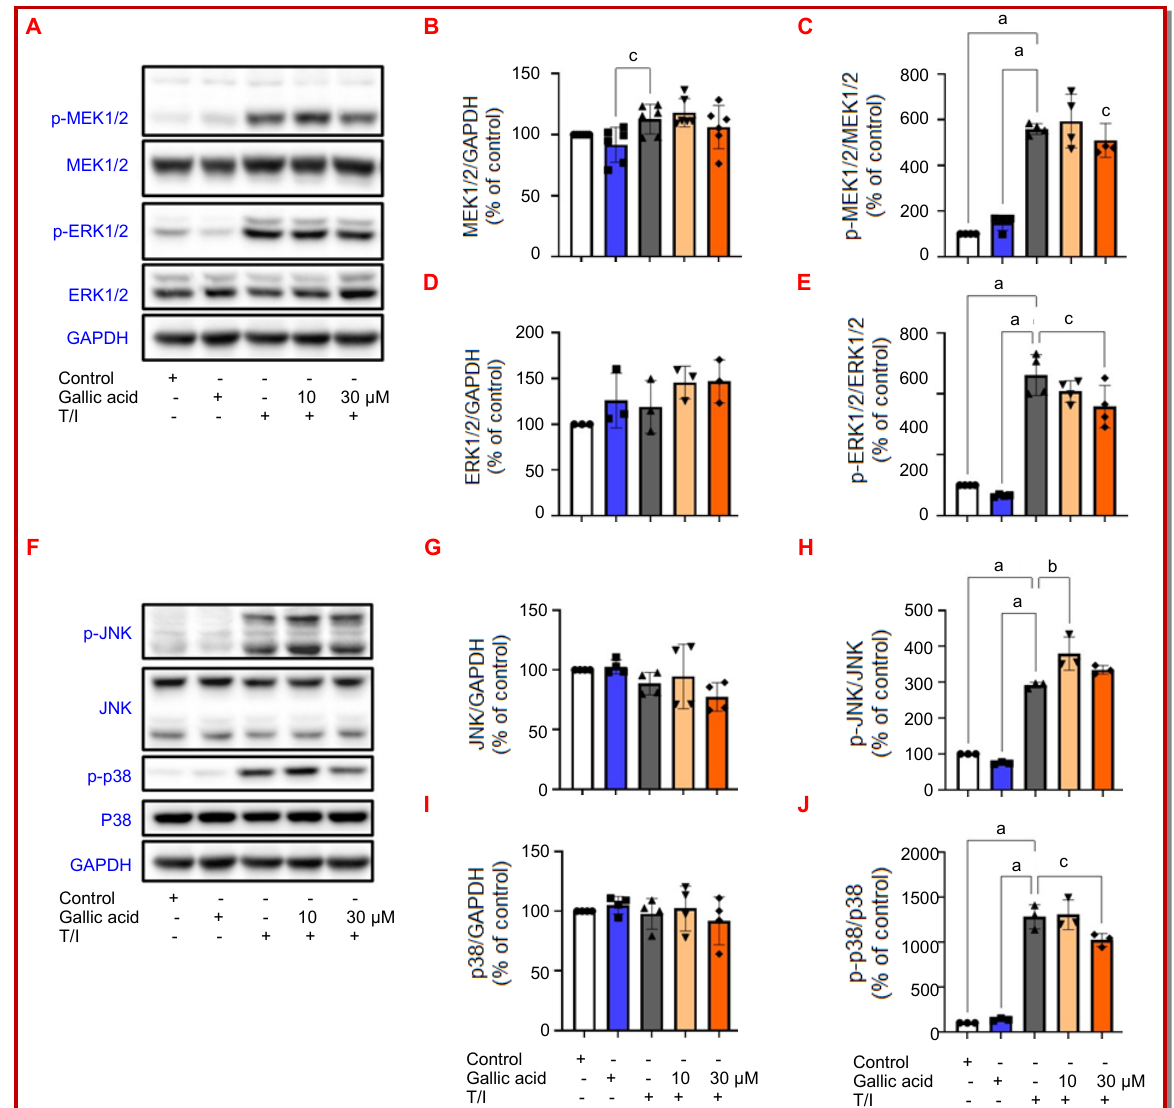
Figure 3: Effects of gallic acid on total and phosphorylated protein levels of MEK1/2, ERK1/2, JNK and p38 MAPK in HaCaT keratinocytes. HaCaT cells were treated without (control) and with different concentrations of gallic acid in the presence of 10 ng/ mL recombinant human TNF-a and 10 ng/mL IFN- γ (T/I) for 24 hours. Protein expression levels of MEK1/2, p-MEK1/2, ERK1/2, p-ERK1/2, JNK, p-JNK, p38 MAPK, and p-p38 MAPK in HaCaT cells were determined using western blotting analysis. GAPDH was used as a reference and the amounts of different proteins were normalized to that of GAPDH. Data are presented as a percentage of control group values (mean ± SD of three to six independent experiments). a p<0.0001, b p<0.01, and c p<0.05